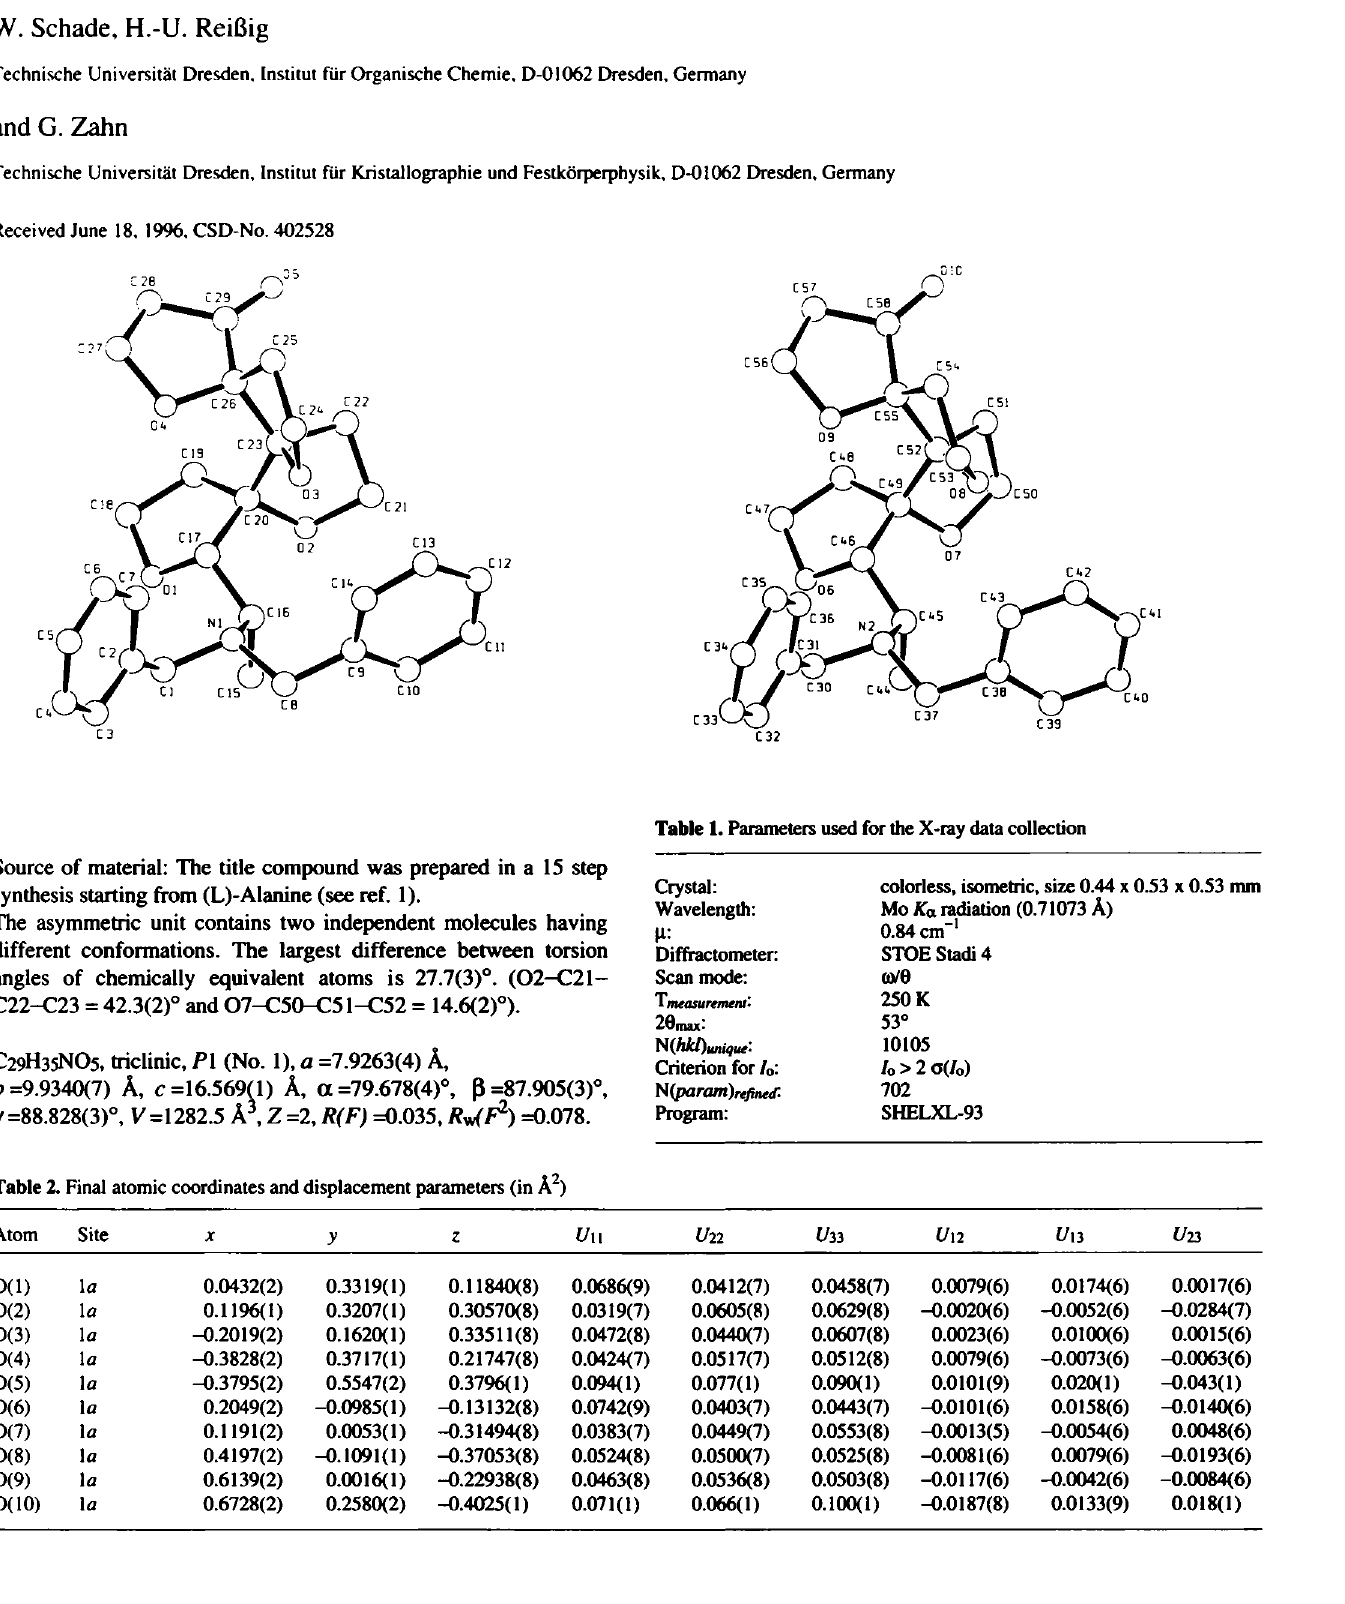
Table 2. Final atomic coordinates and displacement parameters (in Â 2 )